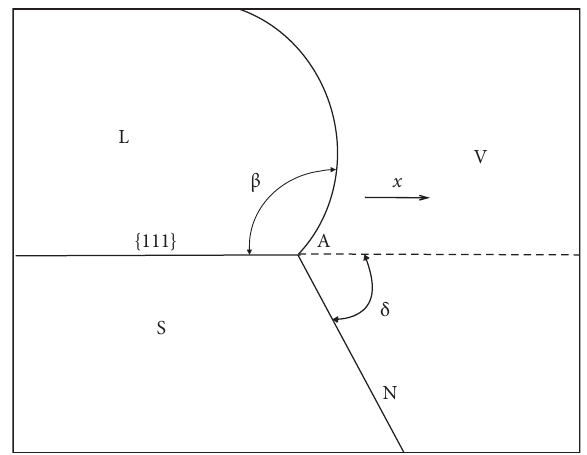
Figure 8: Stop of the droplet spreading contour (TPL) at the fracture AN on the NW tip